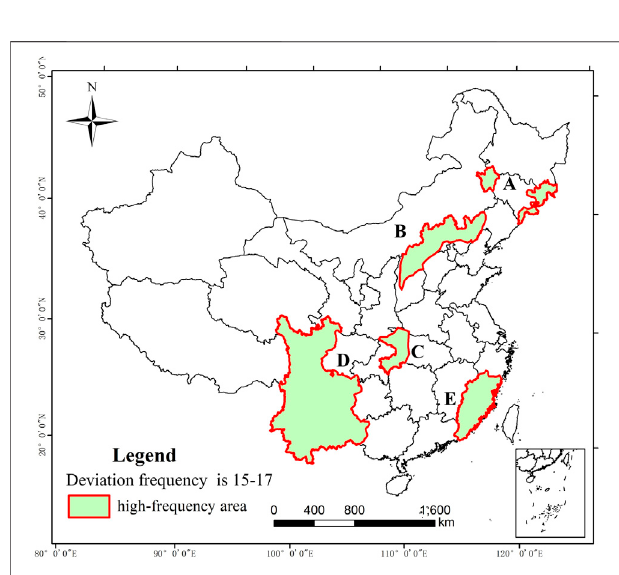
Frontiers in Environmental Science |